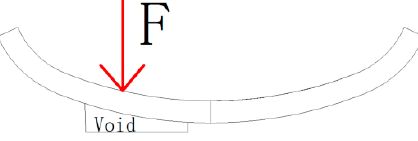
Figure 11. Schematic of the base void.